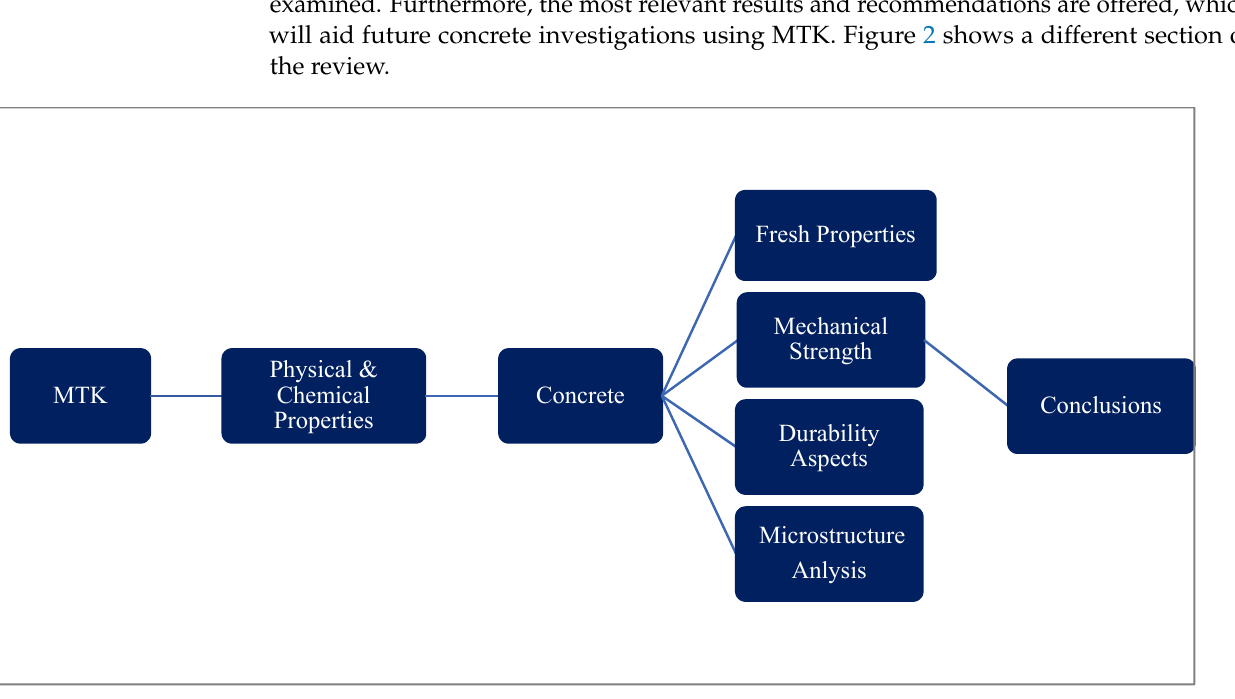
Figure 2. Different sections of the review.